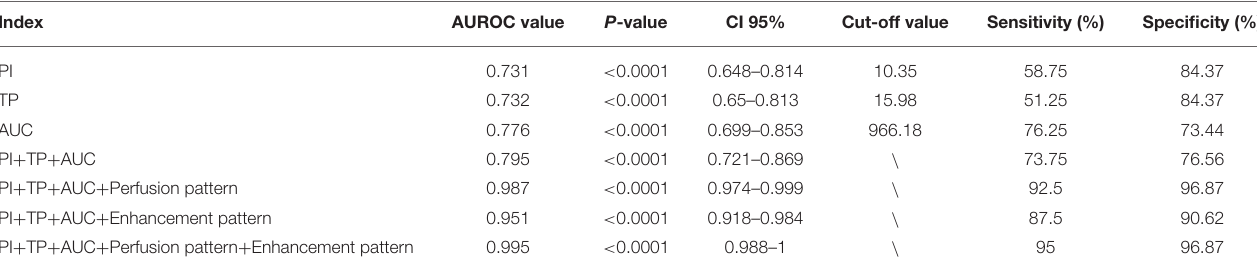
TABLE 3 | ROC analysis: benign vs. malignant